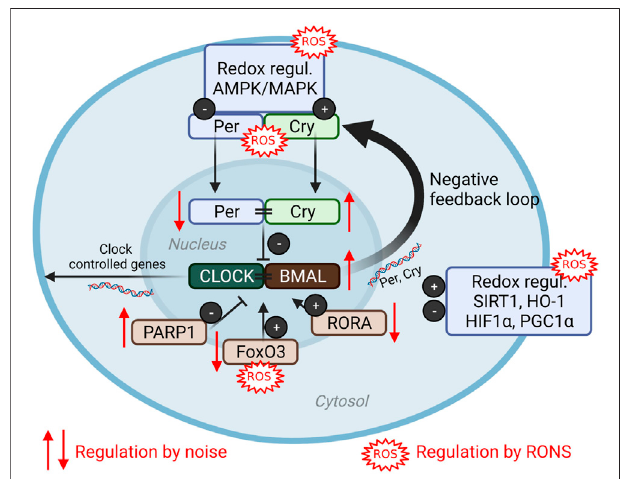
FIGURE4 | (Redox) dysregulationof circadian clock by noise. The clock core components consist of the positive regulators circadian locomotor output cycles protein kaput (CLOCK) and brain and muscle Arnt-like protein (BMAL) that directly control circadian gene expression as well as the negative regulators period (PER) and cryptochrome (CRY) (Van Laake et al., 2018).Numerouscomponentsareredoxregulated(reviewedinLietal.,2020) and modi fi ed by aircraft noise exposure of mice (Kroller-Schon et al., 2018). ROS, reactive oxygen species; AMPK, AMP-activated protein kinase; MAPK, mitogen-activated protein kinase; PARP1, poly (ADP-ribose) polymerase-1; FoxO3, forkhead box O; RORA, RAR-Related Orphan Receptor; SIRT1, sirtuin 1; HO-1, heme oxygenase 1, HIF1 α , hypoxia-inducible factor 1alpha; PGC1 α , peroxisome proliferator-activated receptor gamma coactivator 1- alpha; RONS, reactive oxygen and nitrogen species. Scheme summarized from (Li et al., 2020) with permission under the the terms of the